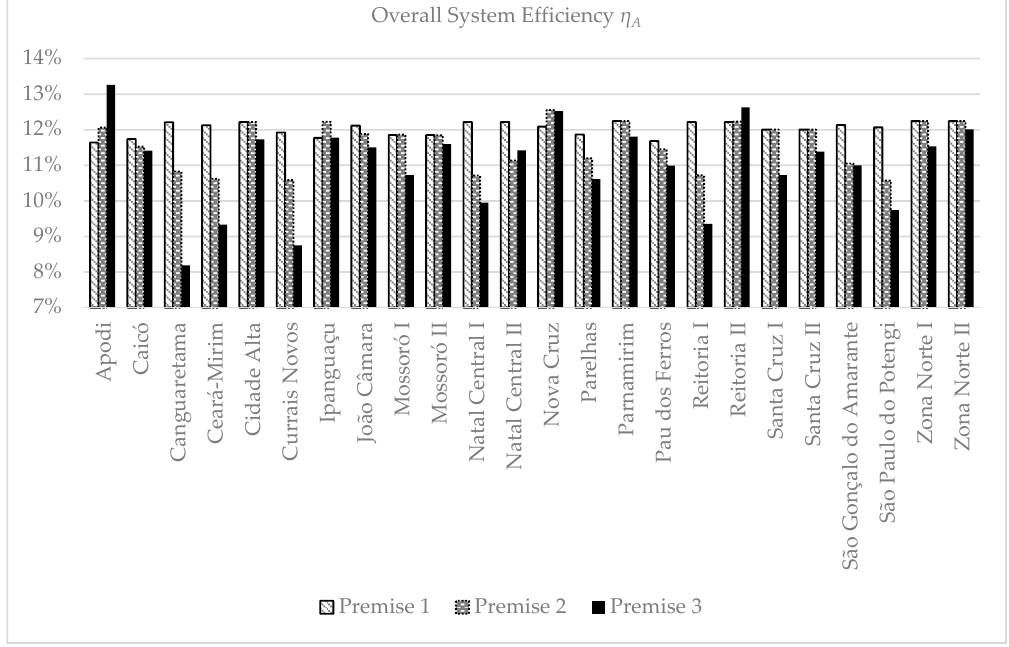
Figure 6. Global System Efficiency, η A , for the IFRN-Solar project plants considering Premises 1, 2, and 3.